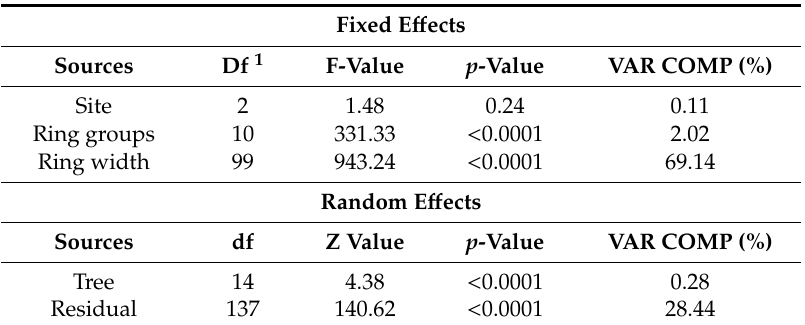
Table 3. Linear mixed model analysis of variance, with F-values for fixed e ff ects, Z-values for random e ff ects, their significance and the variance component (VAR COMP) of each source of variation for wood density in T. occidentalis